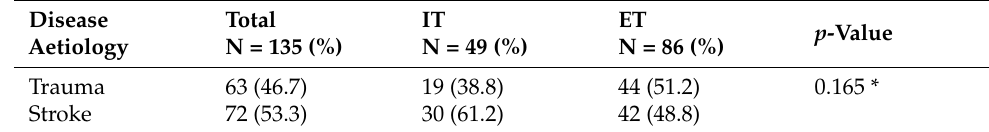
Table 4. Timing of tracheostomy by disease aetiology.